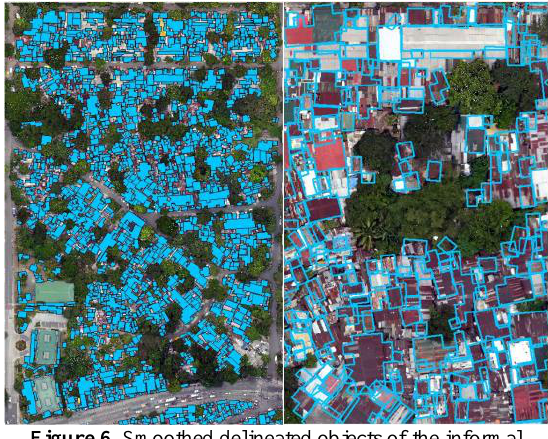
Figure 6. Smoothed delineated objects of the informal settlement structures.